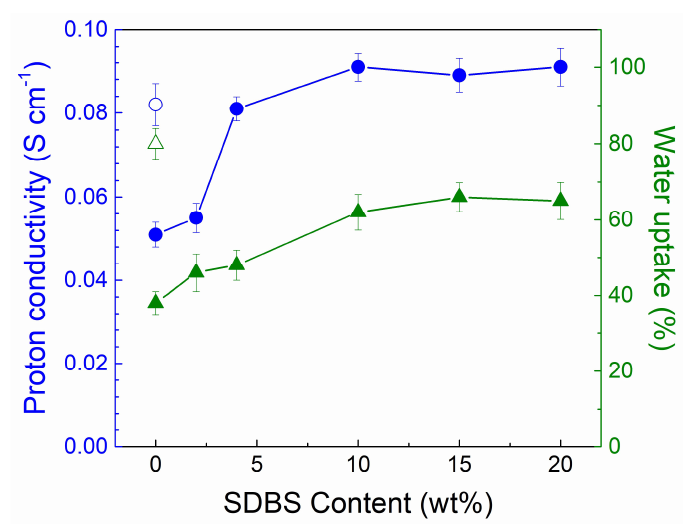
Figure 4. Proton conductivity and water uptake of SPEEK/SDBS membranes (solid symbols) with various SDBS contents and a SPEEK membrane with a degree of sulfonation (DS) of 73% (open symbols)